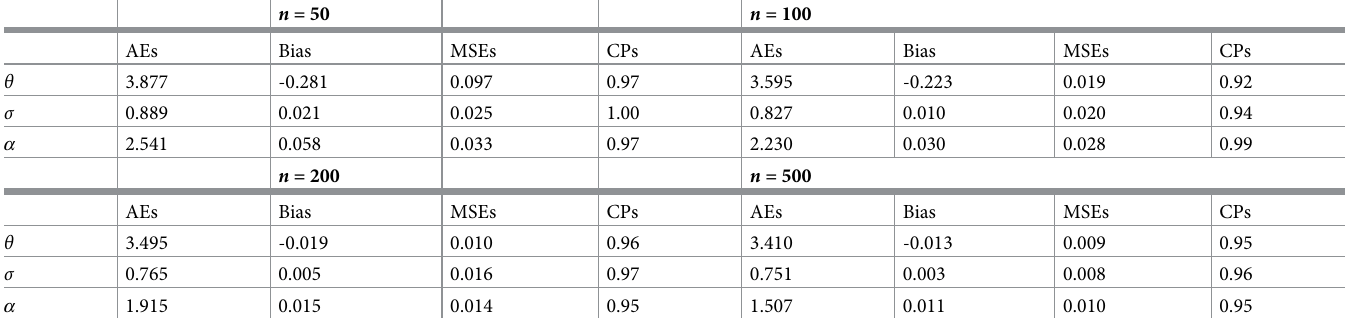
Table 7. AEs, Biases, MSEs and CPs for